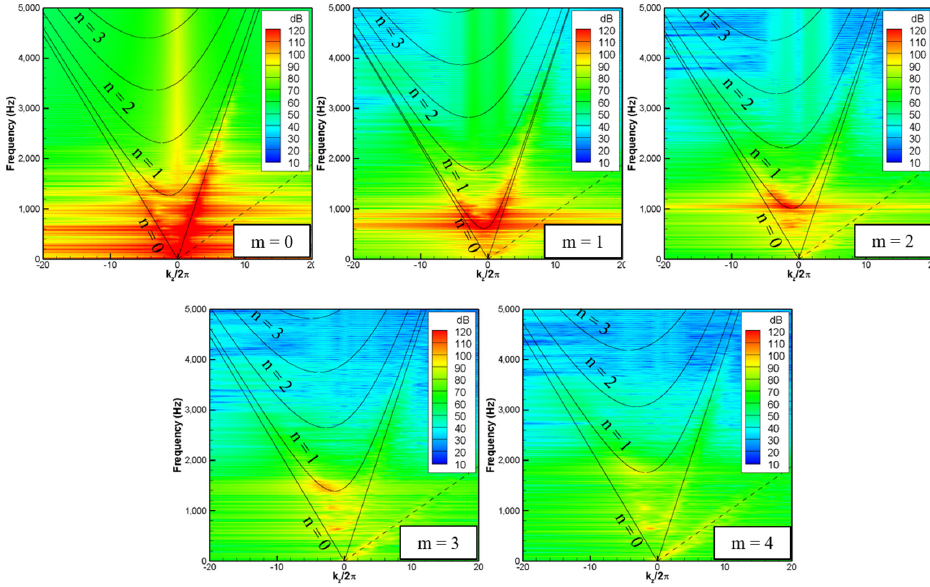
Appl. Sci. 2017 , 7 , 1137 Figure 13. Wavenumber ‐ frequency diagram of surface static pressure on cylindrical plane r = d /2. Figure 13. Wavenumber-frequency diagram of surface static pressure on cylindrical plane r = d /2.